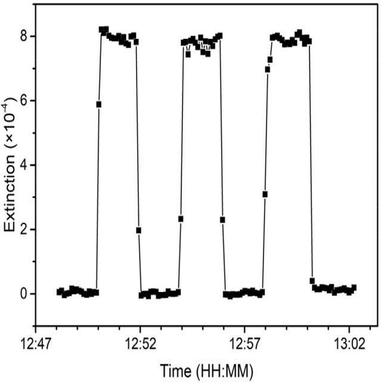
The validation of the OT-CRDS system's stability and reproducibility by repeatedly measuring the extinction of a single MA particle when it is moved outside the ringdown beam or at the center of the ringdown beam. .